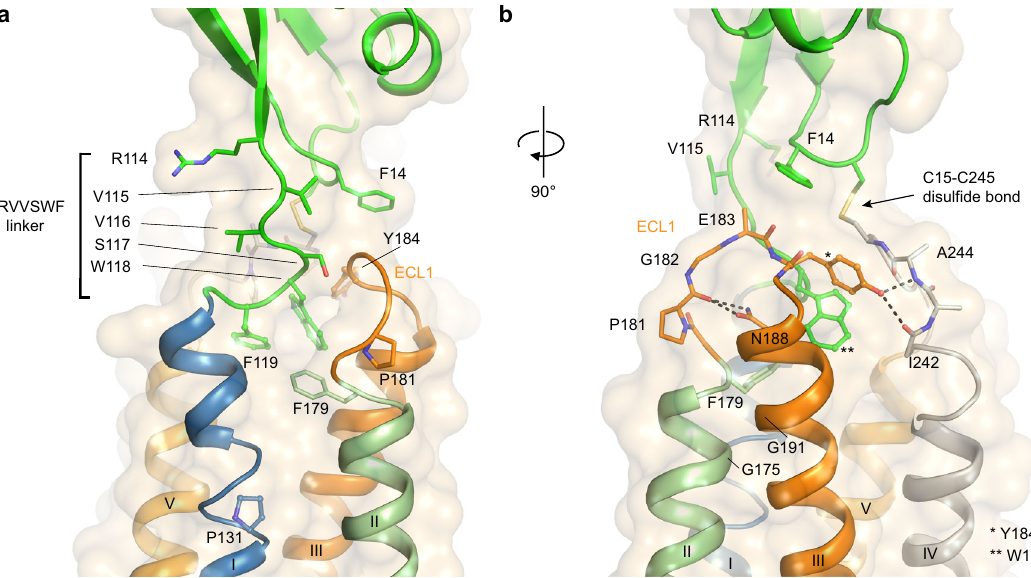
Fig. 2 Interactions within the ECLR and 114 RVVSWF 119 linker. a View of the 114 RVVSWF 119 six-residue peptide linker in the CD47 BRIL -B6H12 crystal structure (green cartoon and sticks), and the insertion site of the 117 SWF 119 loop in the ECLR core. The ECD is shown as green cartoon and the TMD helices are colored blue (helix I), light green (helix II), orange (helix III) and light orange (helix V). The ECL1 is shown as orange cartoon and sticks. b A 90 degree rotation of CD47 BRIL -B6H12 structure view shown in ( a ) highlighting the ECL1 hydrogen bonds (black dotted lines) between Y184 side chain and ECL2 (main-chain atoms shown as gray sticks and labeled), and between N188 side chain and ECL1 (orange